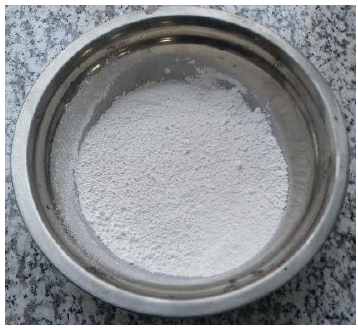
Figure 1. Appearance of nano-TiO 2 /CaCO 3 (NTC).